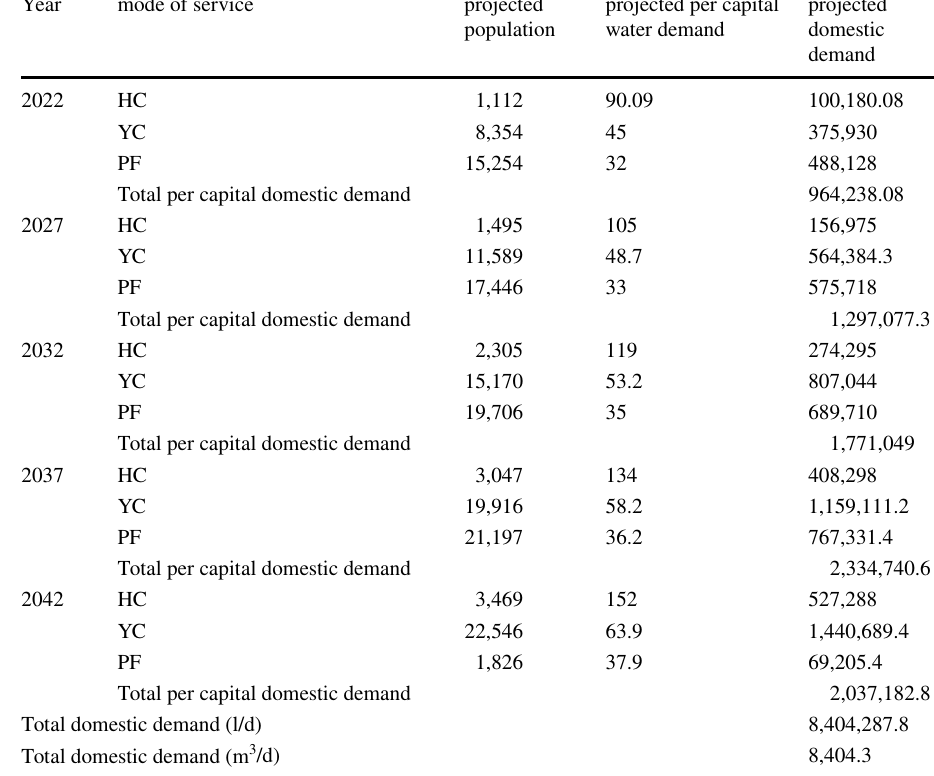
Table 5 Projected daily